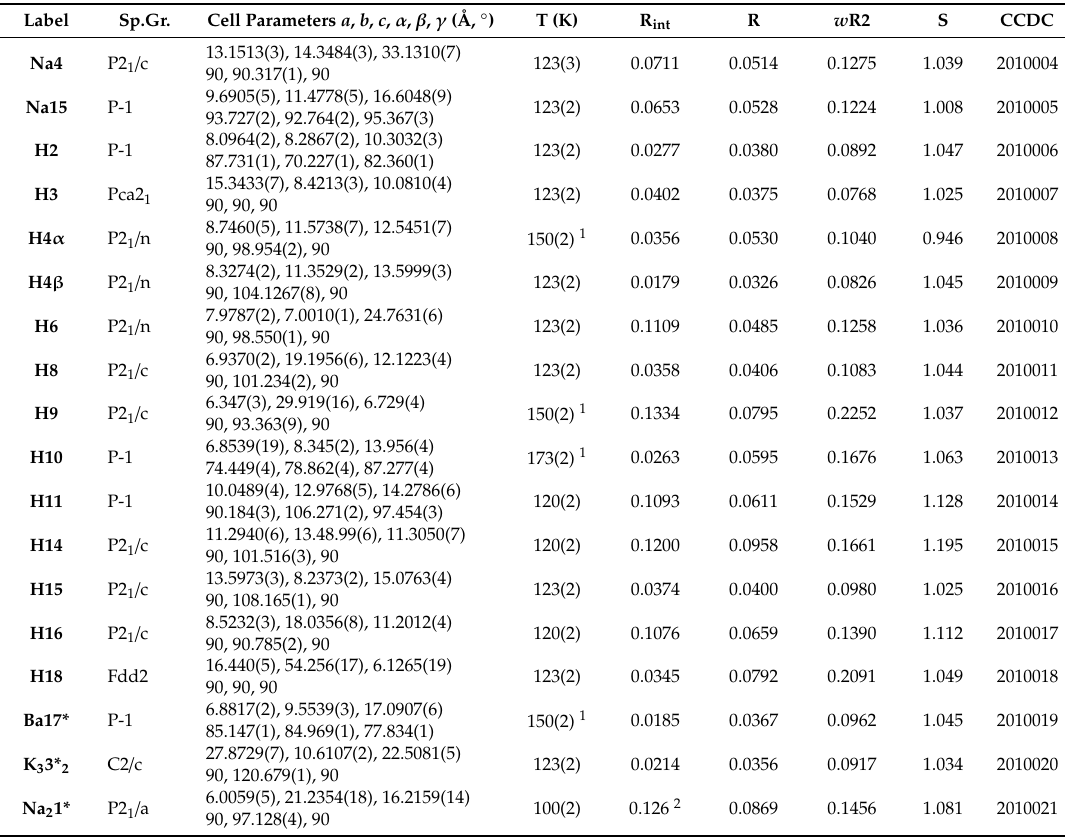
Scheme 1. Diagram showing the main monosulfonated azo species investigated. Compounds are arranged in approximate order of increasing resonance electron donating power of D. In the text, an asterisk (e.g., 1* ) is used to denote a hydroxyl species that has been deprotonated to give the corresponding dianion. Table 1. Selected Crystallographic Data and Refinement Parameters. R based on F where [ I > 2 σ (I)], w R2 = based on F 2 and all reflections.